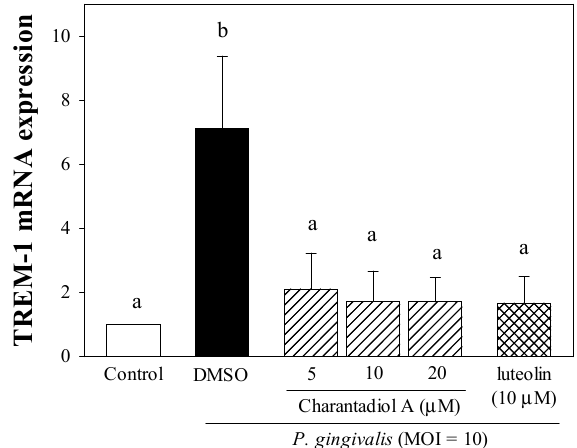
Figure 4. Effect of charantadiol A on P. gingivalis -induced triggering receptors expressed on myeloid cells-1 (TREM-1) mRNA expression. THP-1 cells were cultured with 0.1% ( v / v ) DMSO (vehicle control), or co-incubated with P. gingivalis (M.O.I. = 10) and different concentrations of charantadiol A (5, 10 or 20 µ M) for 4 h to determine the TREM-1 mRNA levels. Experiments were performed three times in triplicate. Each value shows the mean ± SD. Values with different letters are significantly different at p < 0.05.